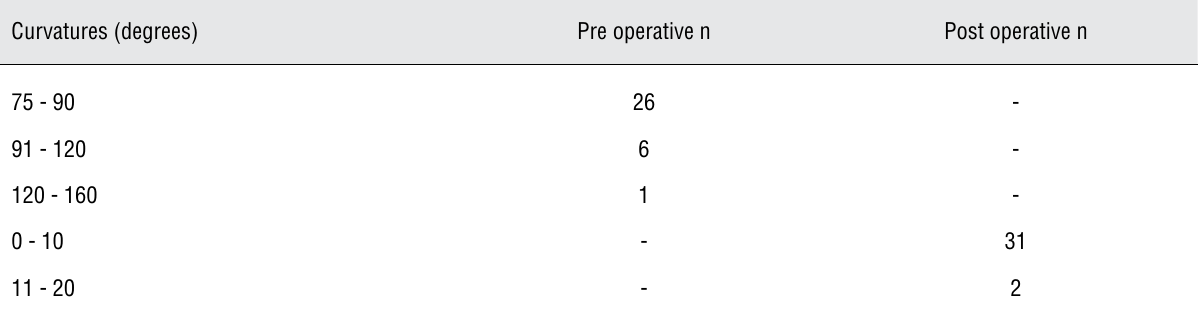
Table 1 - Pre and post operative